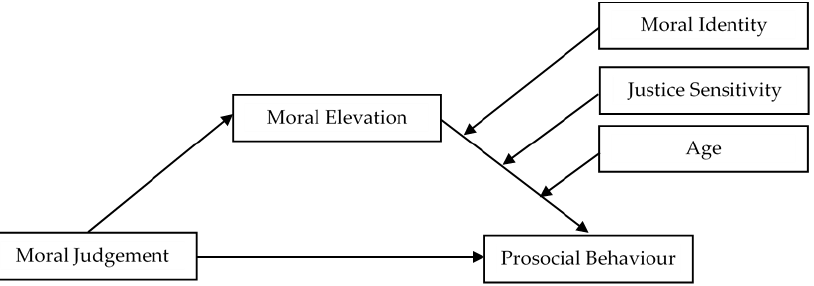
Figure 1. Conceptual model of the relationships between moral judgement, moral elevation, moral identity, justice sensitivity, age, and prosocial behaviour.